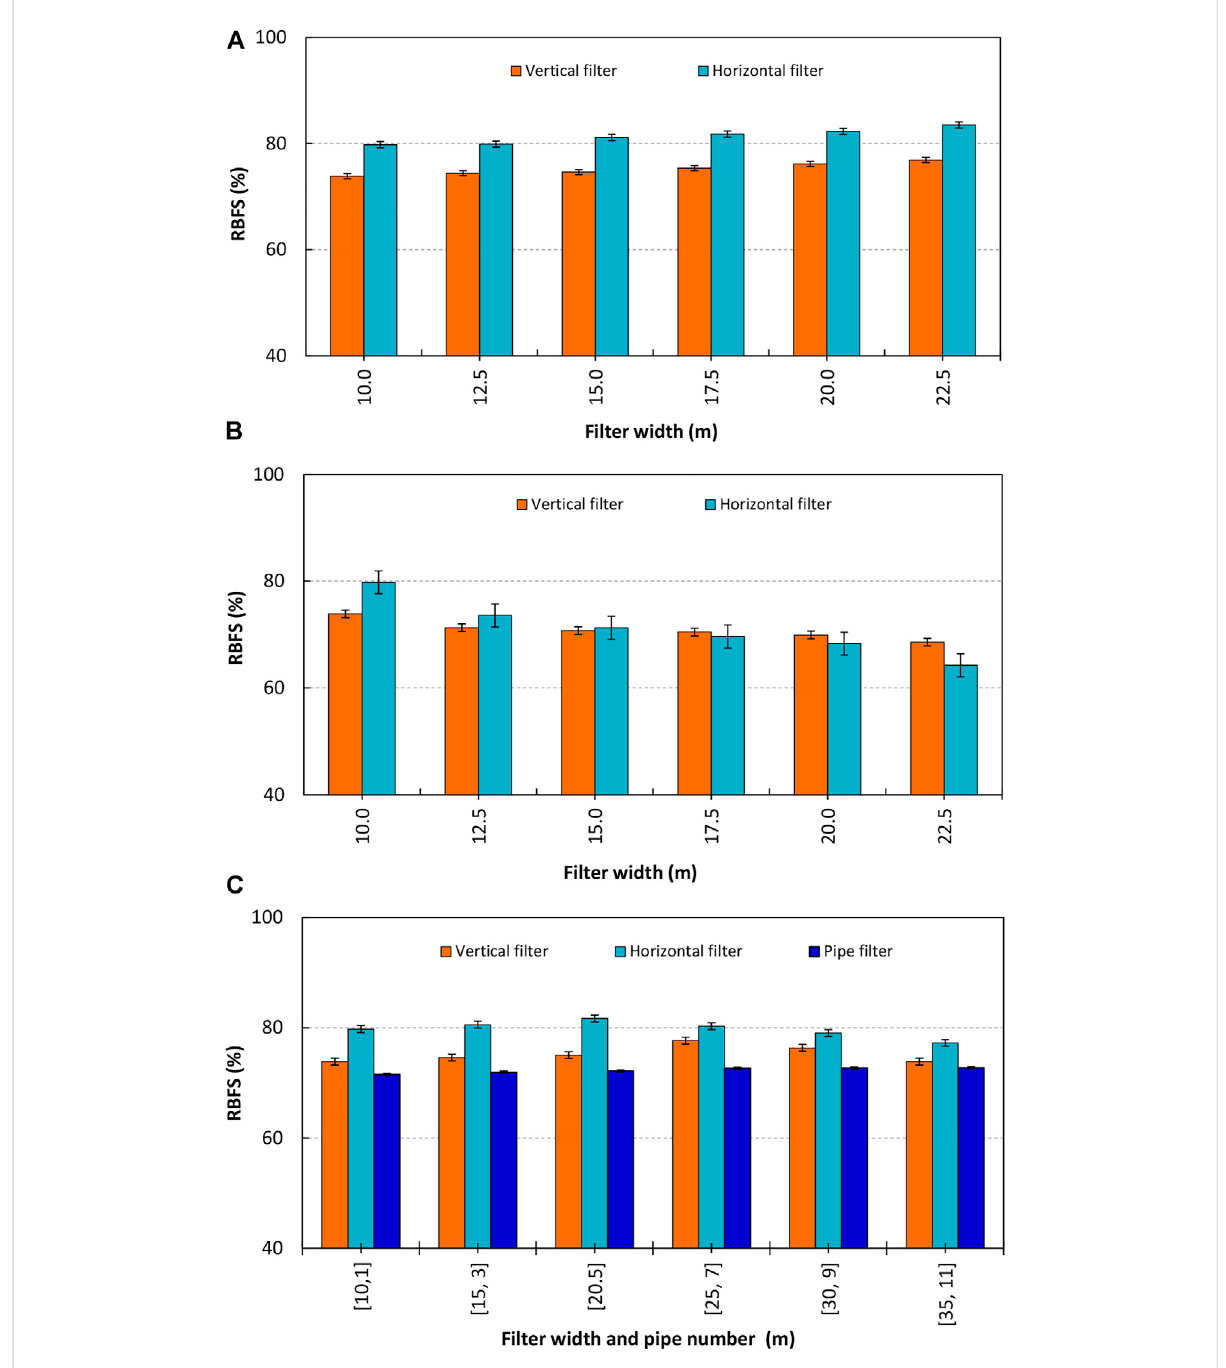
FIGURE 9 Riverbank fi ltrationef fi ciencyfor (A) fi lterwidthriverside, (B) fi lterwidthgroundwaterside,and (C) fi lterwidthbothsidesandriverpipenumbers.